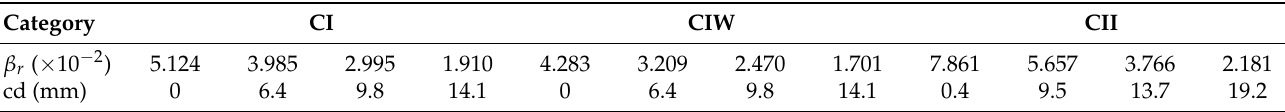
Table 4. The average non-linear parameters with carbonation depth(cd).